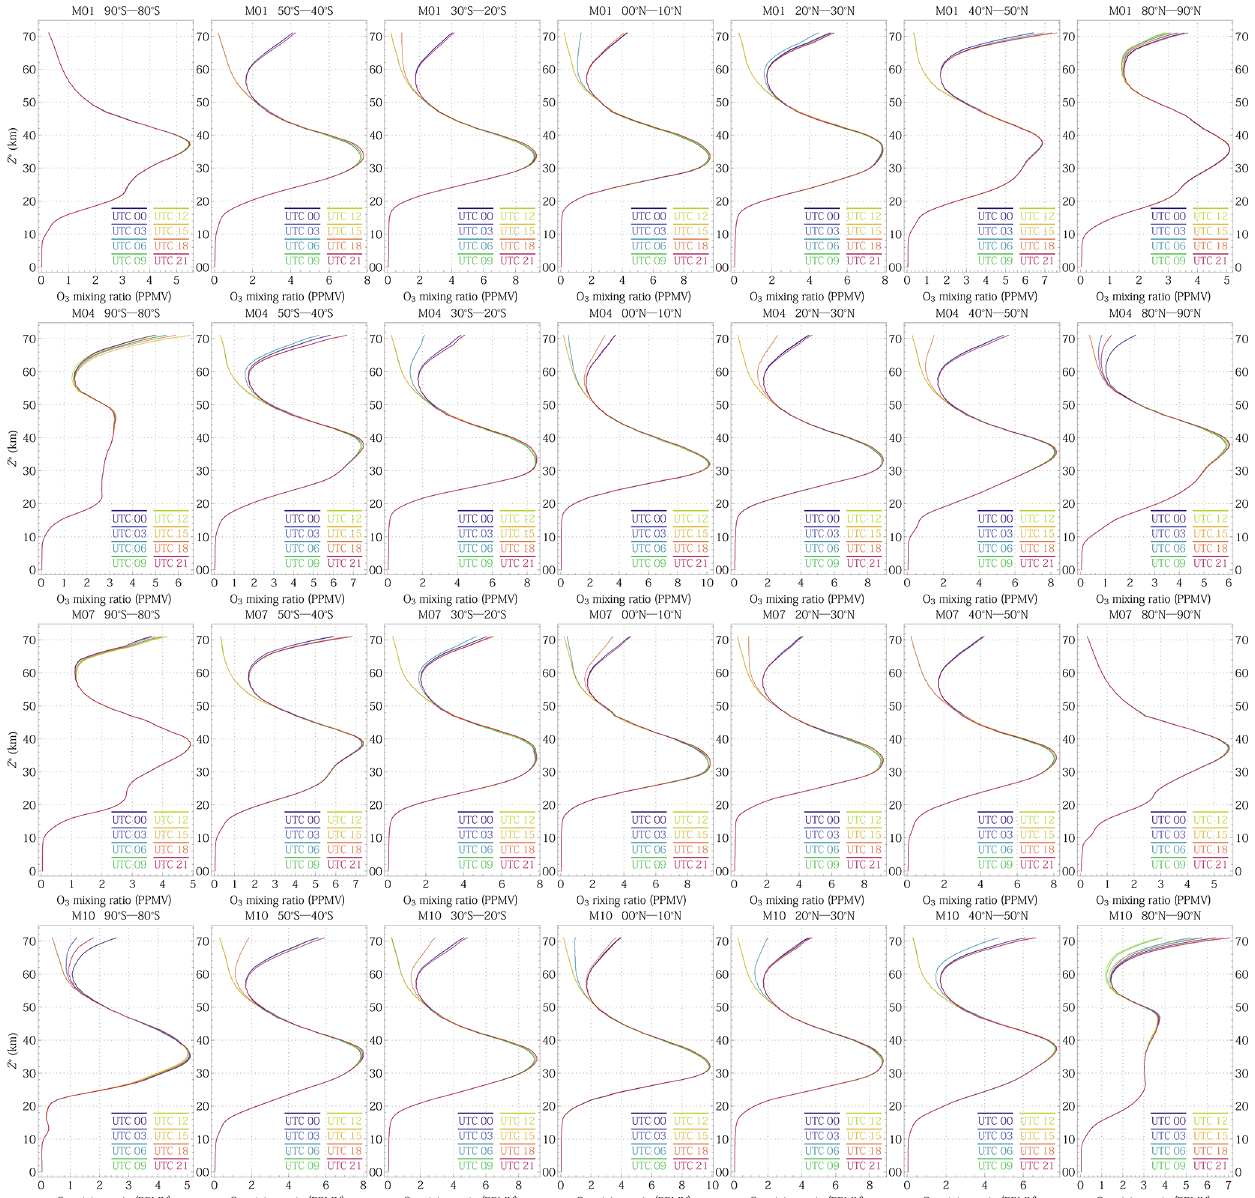
Figure 2. MERRA-2 monthly mean O 3 profiles for four months (January, April, July, and October) and seven tiles that cover the same longitude range (0–15 ◦ E) and seven different latitude zones (90–80 ◦ S, 50–40 ◦ S, 30–20 ◦ S, 00–10 ◦ N, 20–30 ◦ N, 40–50 ◦ N, and 80–90 ◦ N). Each profile (plotted as a colored line) is calculated from samples with the same UTC time, with different colors representing different UTC times shown in the legend. These mean profiles are averages over 15 ◦ longitude, which is equivalent to 1h of local solar time (LST).